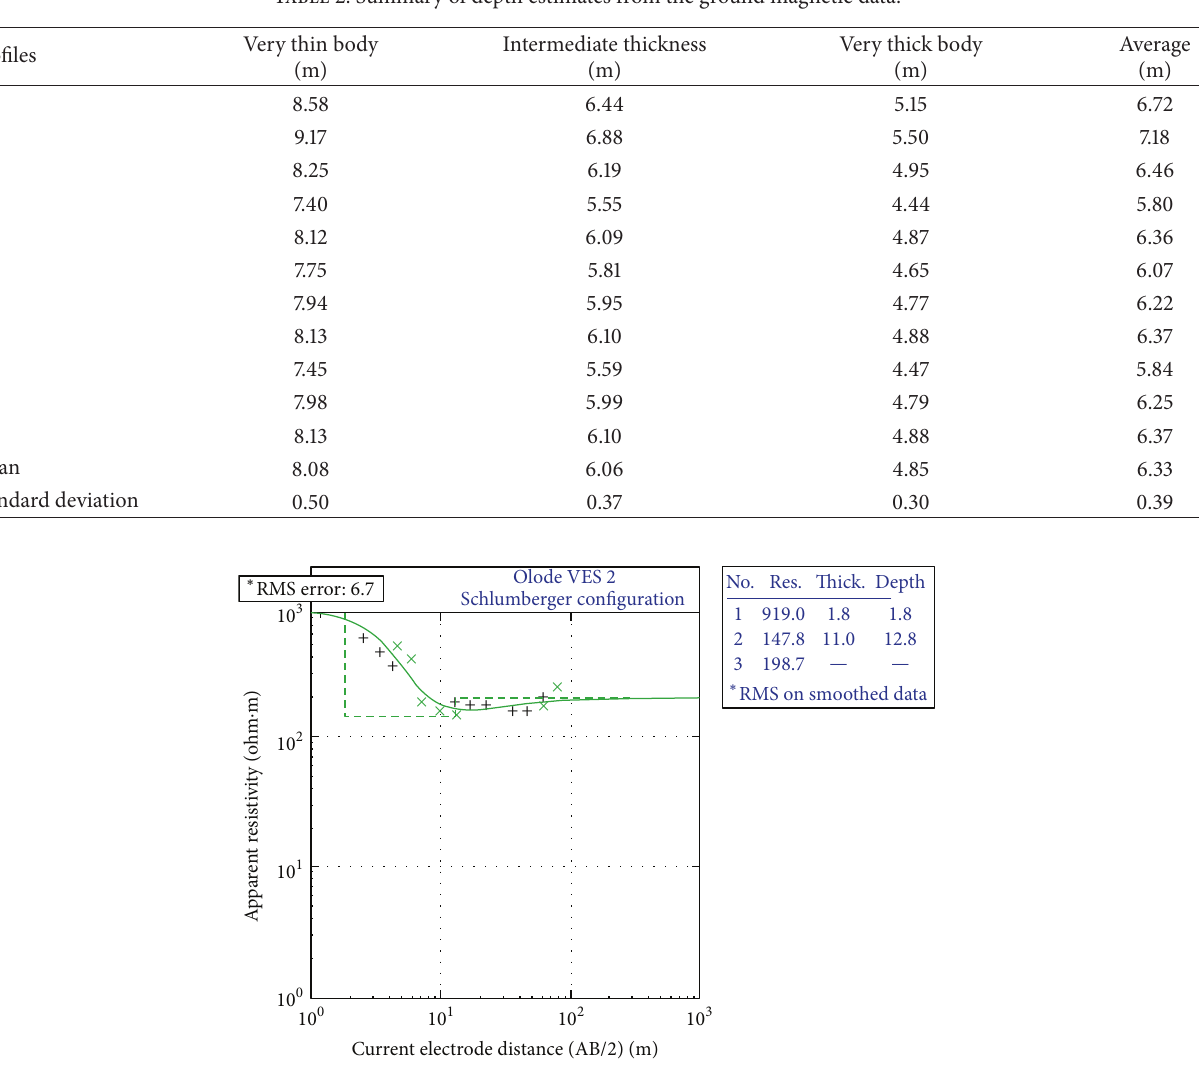
Figure 14: Sounding curve of VES